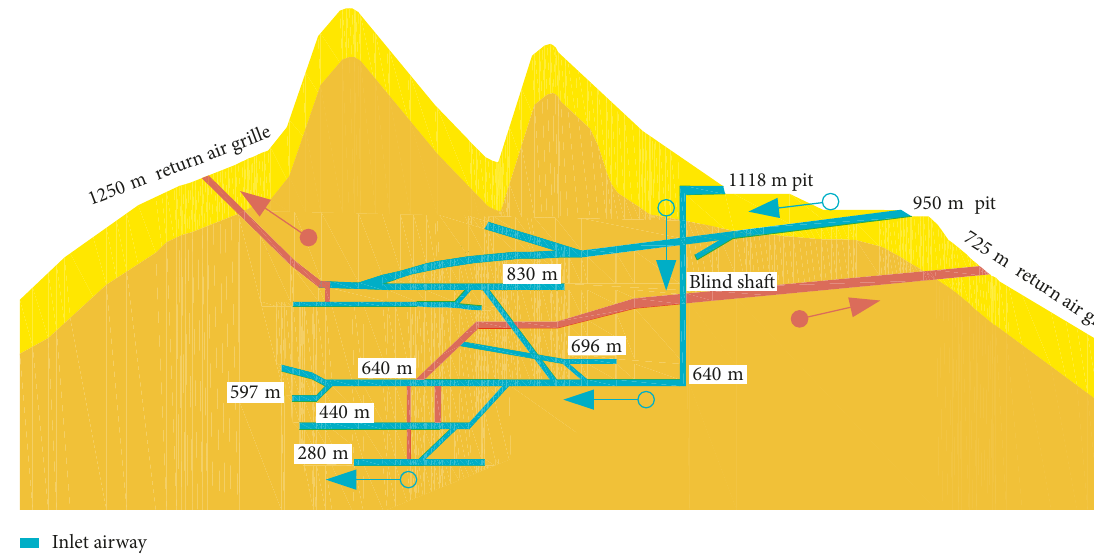
Figure 3: Current status of exploitation in Jinqu Gold